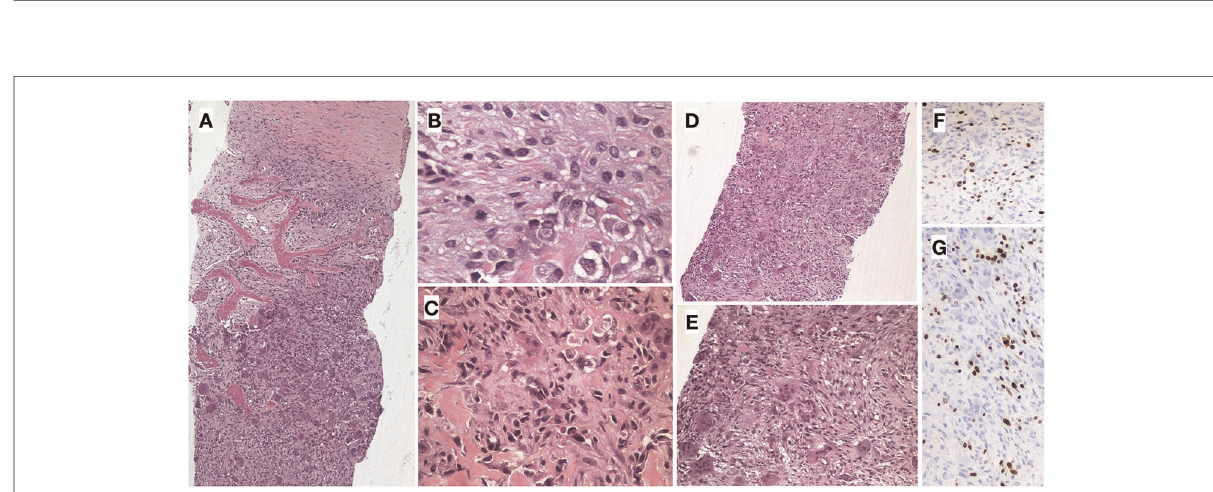
FIGURE 4 Intraoperative images: ( A – E ). Anterior approach: ( A ) Exposure of anterior part of C6-C7 vertebral bodies; ( B ) Tumoral mass within vertebral bodies; ( C ) Preparation of Moss mesh with iliac crest allograft; ( D ) Placement of mesh with allograft in the cervical spine defect; ( E ) Anterior plate fi xation. ( F – J ). Posterior approach: ( F ) Exposure of posterior vertebral elements; ( G ) Posterior vertebral arch resection for total piecemeal spondylectomy; ( H ) Spinal cord and roots decompressed; ( I ) Posterior instrumentation fusion C5-T3 with bilateral screws and rods; ( J ) Posterior part of the tumoral piece.